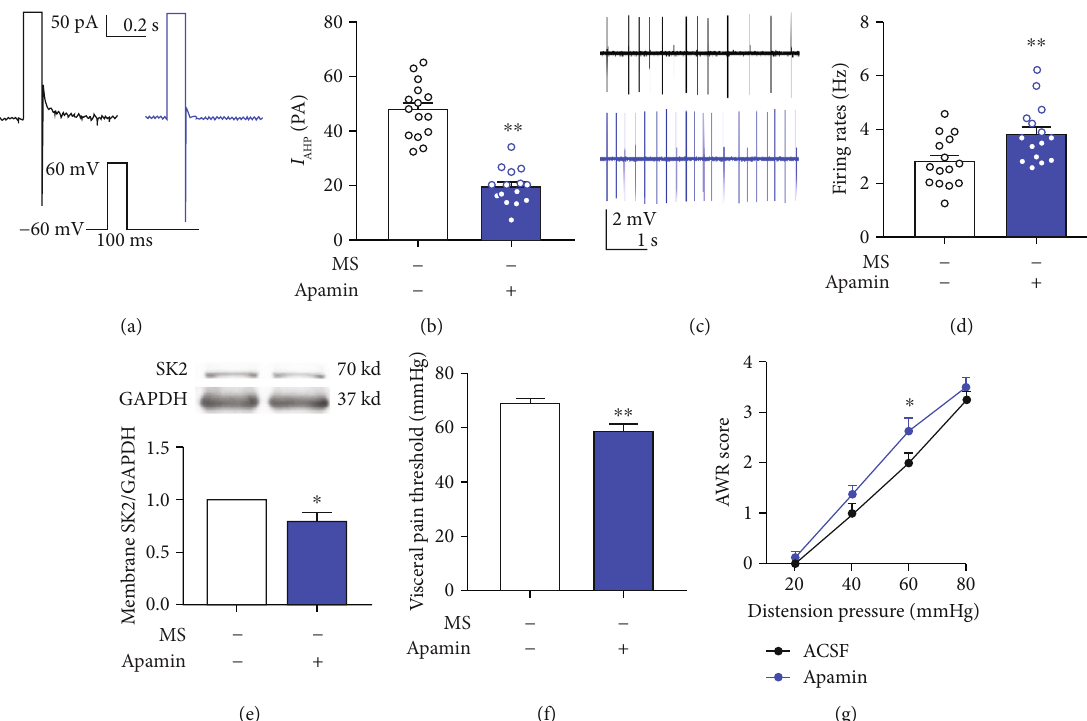
fi ring rates, SK2 protein in membrane fraction, and pain Figure 4: E ff ects of the SK2 channel blocker apamin on I AHP , spontaneous neuronal threshold. (a, b) Apamin injection decreased the amplitude of I AHP in naïve mice ( t -test, t = 8 : 97 , P < 0 : 01 , n = 15 neurons/5 mice per group). (c, d) Apamin injection increased the neuronal fi ring rates in the spinal DH of naïve mice ( t -test, t = 2 : 82 , P < 0 : 01 , n = 15 neurons/5 mice per group). (e) Apamin injection resulted in the decrease of the spinal SK2 channel in membrane fraction in the naïve mice ( t -test, t = 2 : 70 , P < 0 : 05 , n = 6 per group). (f) Apamin administration caused the decrease of the pain threshold in naïve mice ( t -test, t = 3 : 00 , P < 0 : 01 , n = 8 per group). (g) Naïve mice with intrathecal injection of apamin exhibited increased AWR score in response to the distension pressure at 60mmHg (Bonferroni post hoc test, P < 0 : 05 ) (two-way ANOVA test, F ð 1, 14 Þ = 3 : 82 , P = 0 : 07 , n = 8 per group). Data are expressed as mean ± SEM ; ∗ P < 0 : 05 and ∗∗ P < 0 : 01 P < 0 : 05 , Figure 2(c)). The same total distance of travel of motor ability ( n = 8 , P = 0 : 783 , Figure 2(d)). Mice with